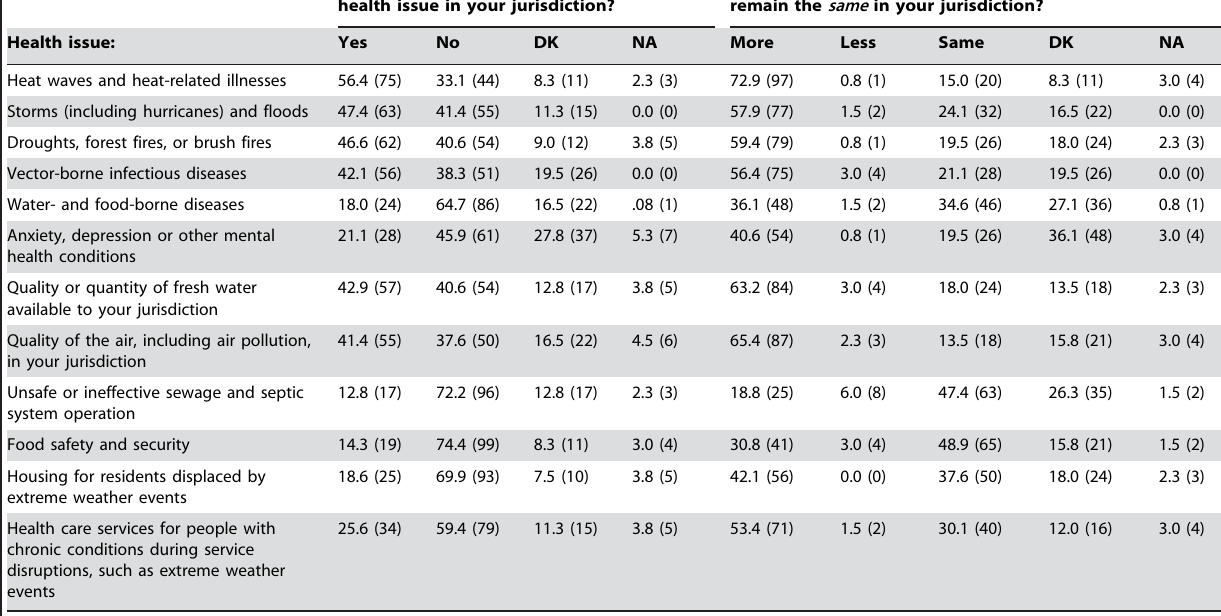
Over the next 20 years, will climate change make this issue more common or severe, less common or severe, or will it remain the same in your jurisdiction?